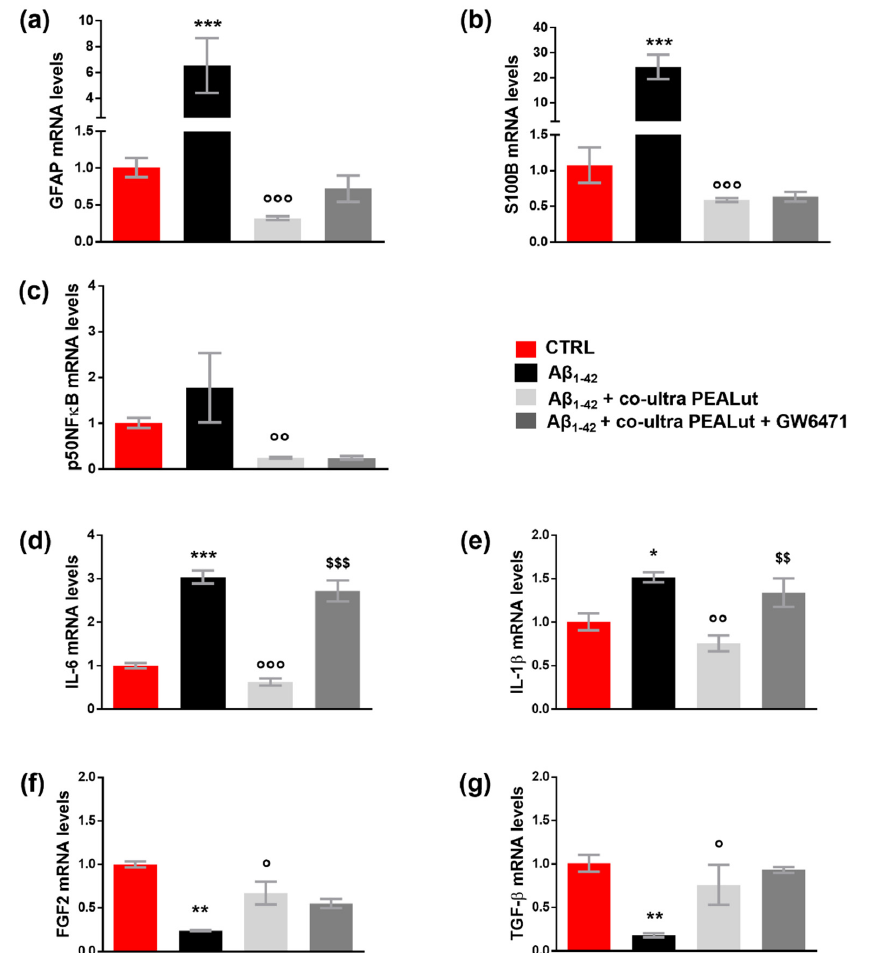
Figure 3. Co-ultra PEALut blunts the A β 1–42 -induced reactive and proinflammatory astrocyte phenotype. Astrocytic transcriptional changes of GFAP ( a ) and S100B ( b ), two markers of astrocyte reactivity, proinflammatory mediators p50NF κ B ( c ), IL-6 ( d ), and IL-1 β ( e ), and growth factors FGF2 ( f ), and TGF- β ( g ). Treatments with human fibrillary A β 1–42 1 µ m in the presence or absence of co-ultra PEALut 3 µ m and GW6471 3 µ m (or respective vehicles) were added to the culture media of primary astrocytes set in co-cultures with OPCs. Primary astrocytes were collected 48 h later and processed for RT-qPCR. Data are expressed as mean ± SEM of the fold change to the vehicle-treated group (CTRL). * p < 0.05; ** p < 0.01; *** p < 0.001 vs. CTRL; ° p < 0.05; °° p < 0.01; °°° p < 0.001 vs. A β 1-42 ; $$ p < 0.01; $$$ p < 0.001 vs. A β 1-42 + co-ultra PEALut (SNK test). Furthermore, our results show that A β 1-42 significantly reduced the gene expression of both astrocytic FGF2 and TGF- β compared with control cells (Figure 3f,g). Co-ultra PEALut treatment significantly prevented such A β 1-42 -induced modifications. However, concurrent treatment with GW6471 did not change the observed co-ultra PEALut effect, thus indicating that the PPAR- α was not engaged.3.4. Co-ultra PEALut counteracts the altered MBP + /Olig2 + ratio triggered by A β 1-42 exposure Experiments investigated whether exposing primary astrocytes to A β 1-42 affects the maturation of co-cultured OPCs and whether co-ultra PEALut prevents the observed A β 1-